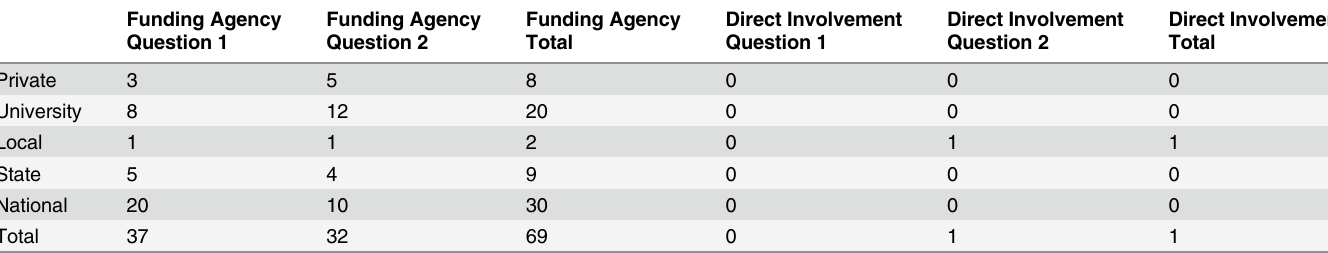
Table 2. Counts of Funding Agency Types and Their Direct Involvement in the Review